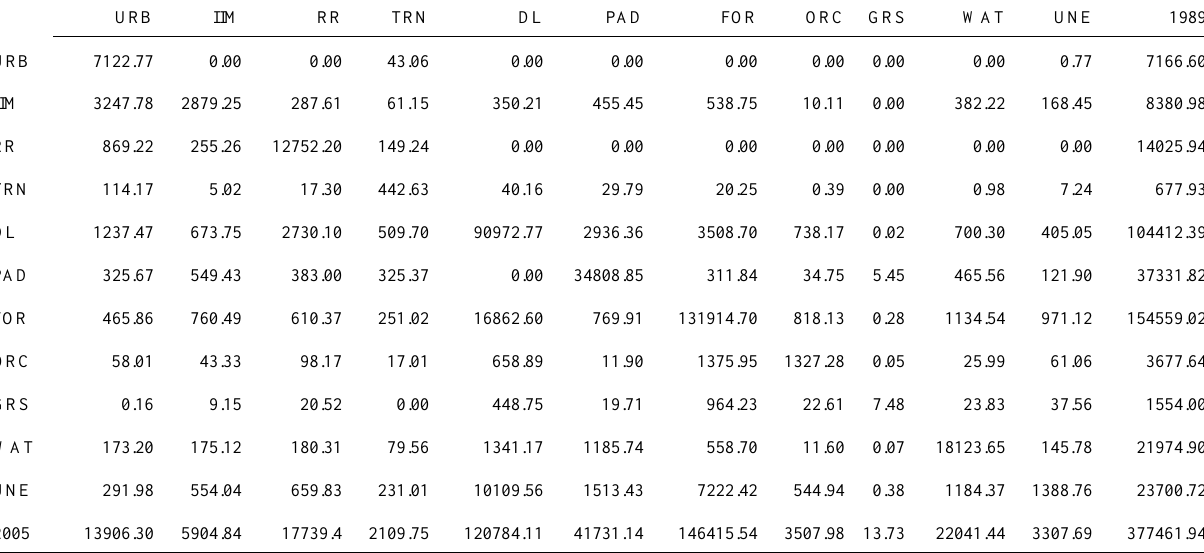
Table 2. Land use change matrix in the metropolitan area of Jilin City between 1989 and